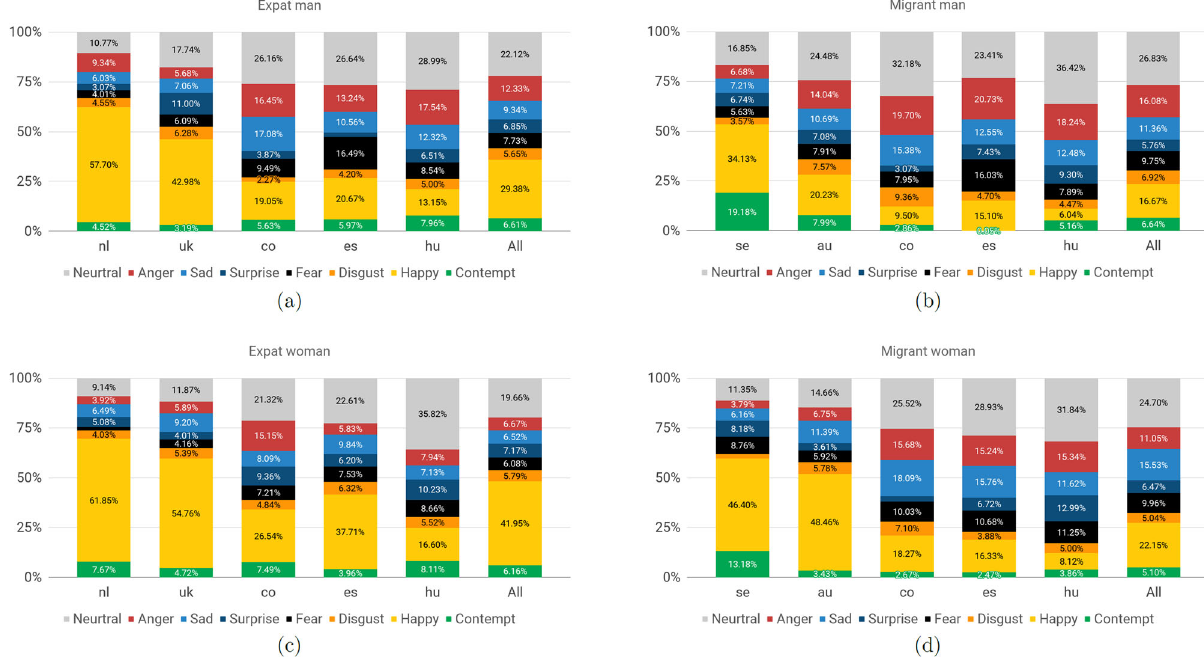
Fig. 5 The distribution of emotions for selected locations. The plots are for the locations Sweden, Australia, Colombia, Spain, and Hungary, and the groups a migrant man, b migrant woman, c expat man, and d expat